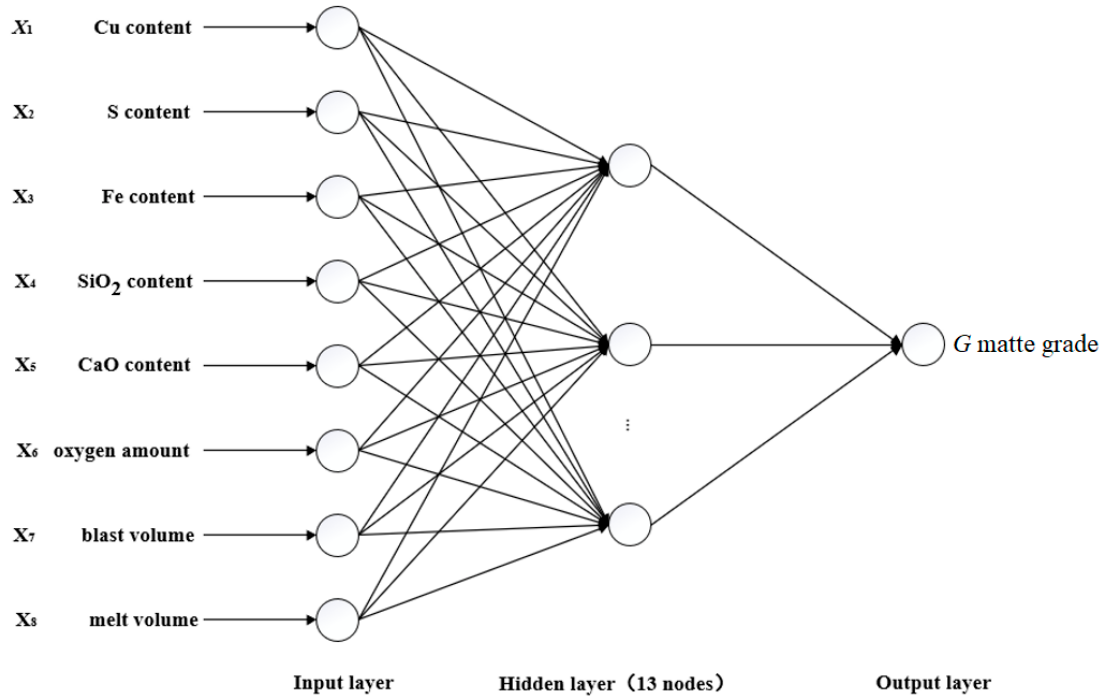
Figure 1. A schematic diagram of the BP neural network prediction model for ma tt e grade.